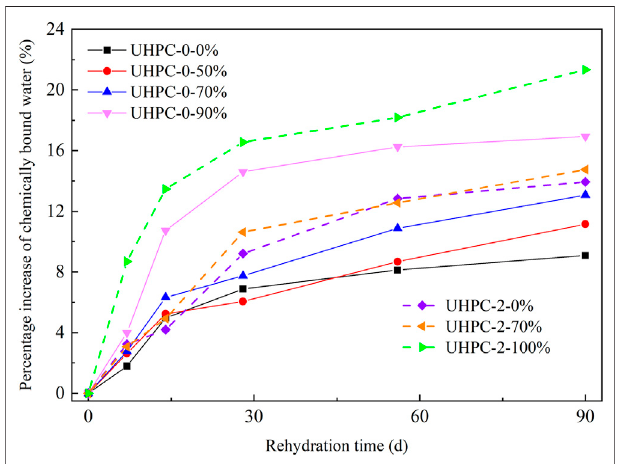
FIGURE 12 | Relationship between the splitting tensile strength of UHPC-0 and its rehydration